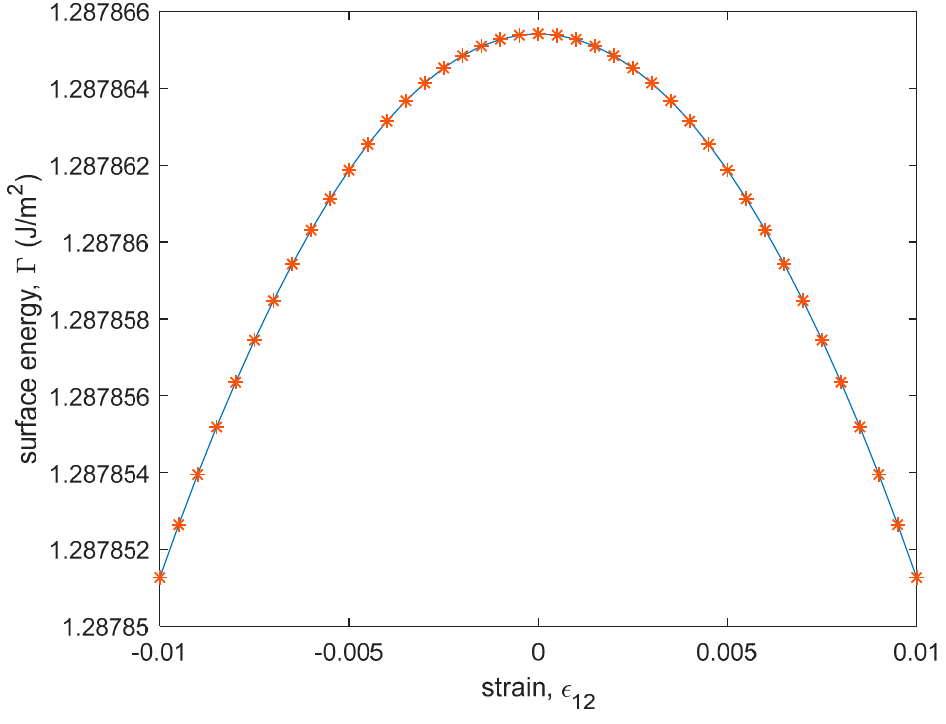
Figure 2. Fitted result between the surface energy and shear strain for Cu(100) surface.